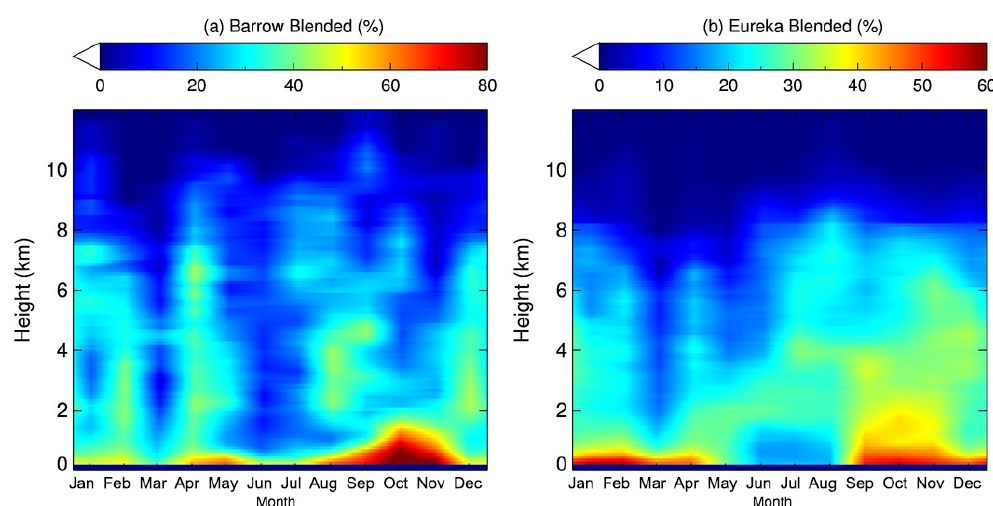
Figure 10. Blended cloud fraction/frequency vertical distribution at Barrow and Eureka with combined surface and space observations from 2B-GEOPROF-lidar for 2006–2010.